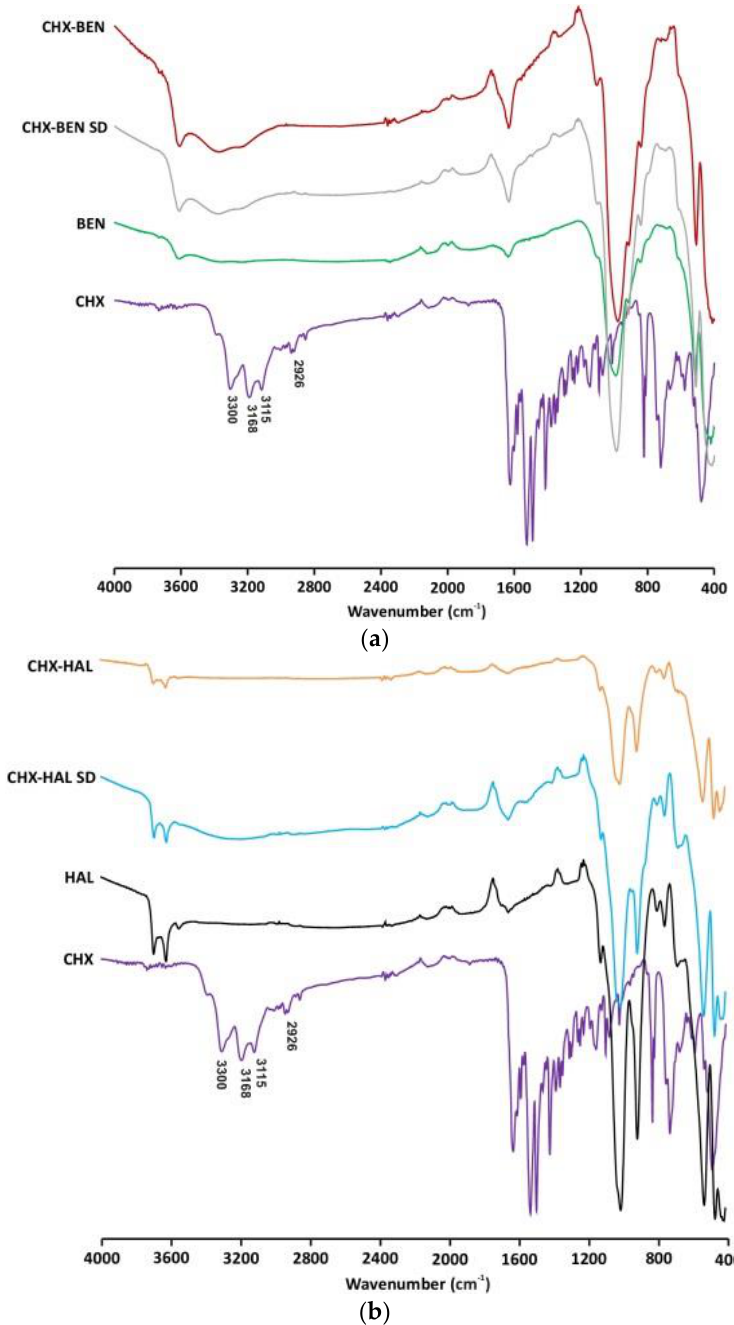
Figure 3. FTIR spectra of nanohybrids and pristine components: ( a ) BEN- – based nanohybrids; ( b )